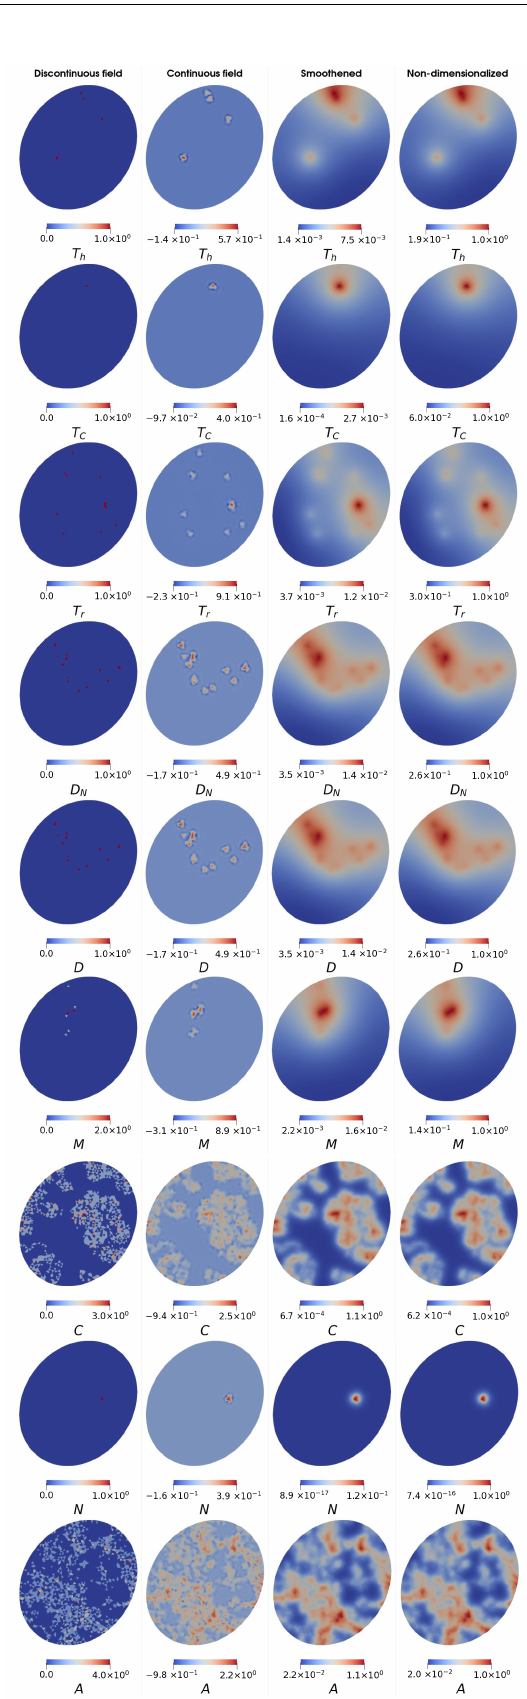
Figure A2. Column 1 : Discontinuous fields. Column 2 : Projection onto a function space with linear La- grangian elements. Column 3 : Smoothened fields via diffusion. Column 4 : Non-dimensionalized